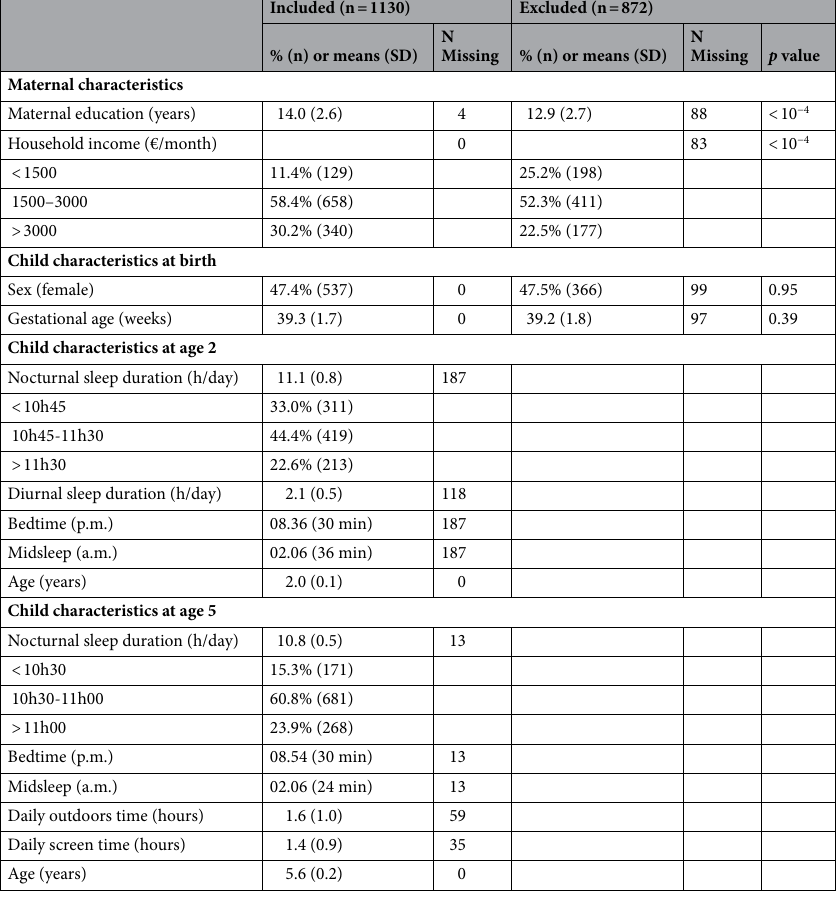
Statistical analyses. All analyses were performed using SAS software. Comparison of included to non- included participants were performed using Chi-squared test and Student’s t-tests. Associations between sleep and refractive errors were analyzed separately for the three studied outcomes (i.e. eyeglass prescription, hyperopia, myopia) using logistic regressions. We performed cross-sectional analyses at age 5 and longitudinal analyses considering sleep duration and timing at age 2 and the existence of refractive errors at age 5. All analyses were first preadjusted for age at the 5 years questionnaire and maternity hospital. Multivariate logistic regressions were adjusted for confounding factors identified from the literature and selected using the Directed Acyclic Graphs (DAG) method (www. dagit ty. net). All models were thus adjusted for mater- nity hospital, maternal age, maternal education, household income, child’s sex, gestational age, and time spent outdoors, daily screen time and season at the 5 years questionnaire completion. Longitudinal models including sleep duration were in addition adjusted for diurnal sleep at age 2. As bedtime and midsleep were strongly cor- related with sleep duration (r = -0.32 and r = 0.40, respectively, both p < 10 –4 ), these variables were not included in multivariate models.